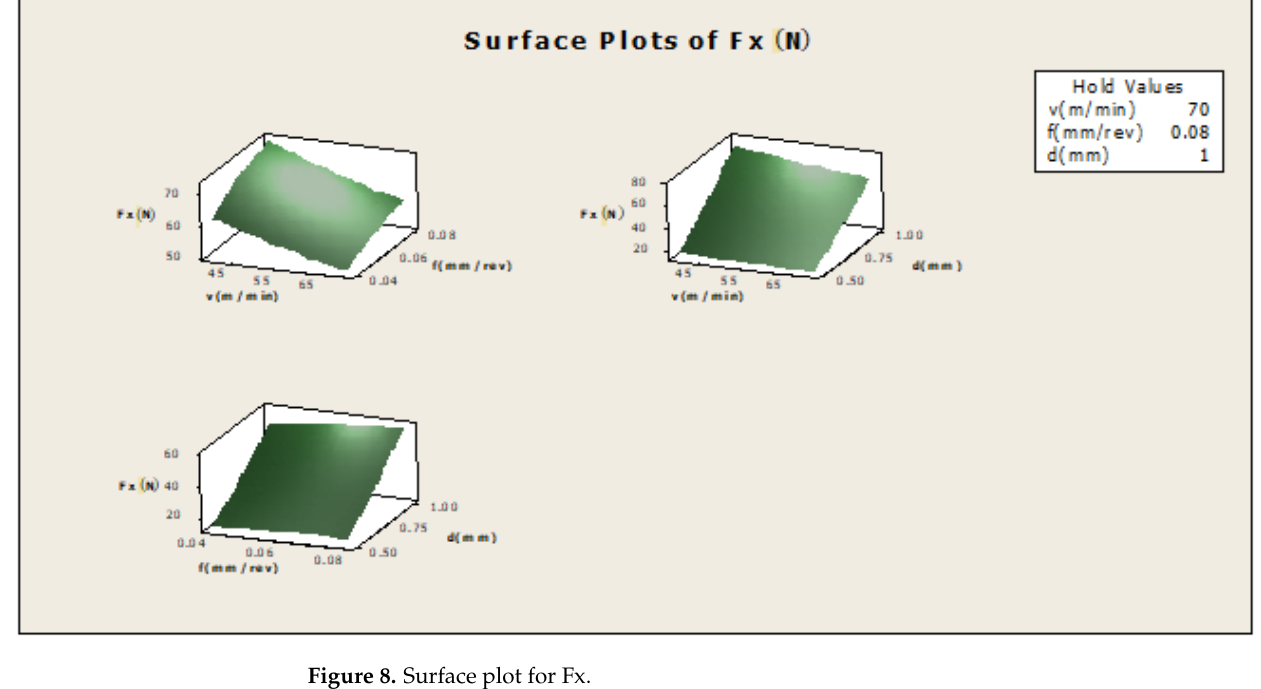
Figure 7. Surface plots for flank-wear.